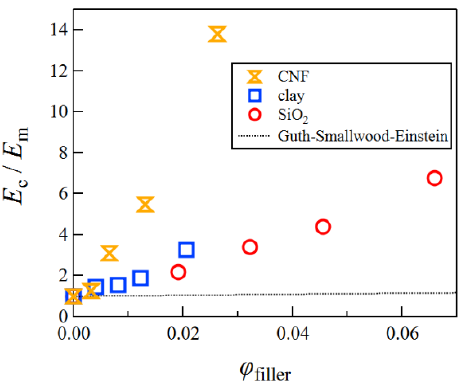
Figure 9. A plot of E c / E m against the volume fraction of the filler for CS/PVA/borax composite hydrogels using various fillers.